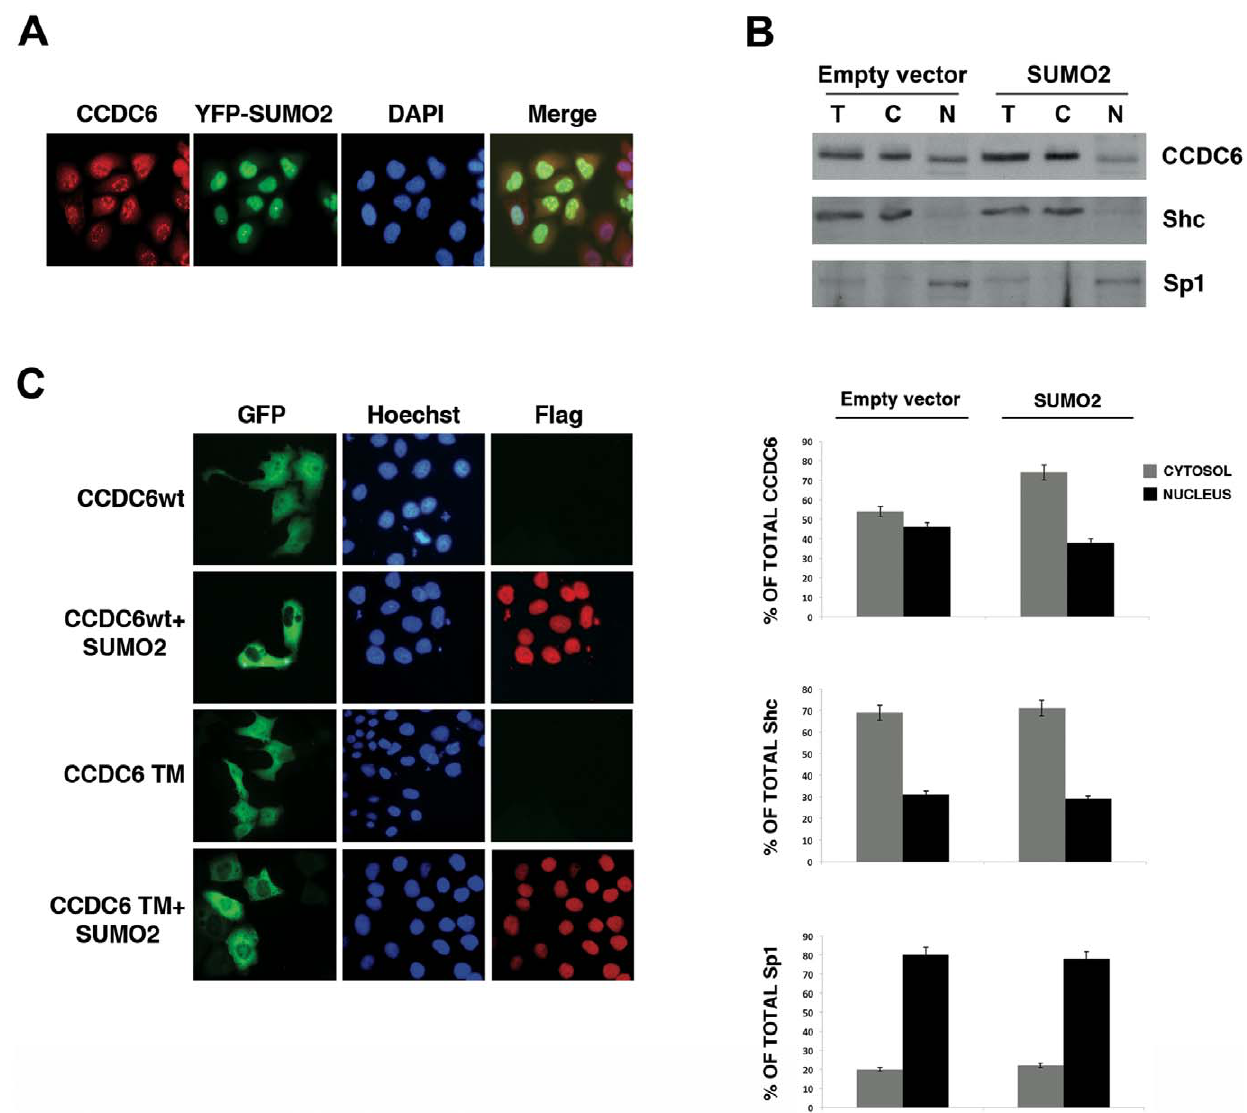
Figure 3. Intracellular localization of CCDC6-SUMO2 complex. A) HeLa YFP-SUMO2 cells were immunostained with the anti-CCDC6 antibody recognizing endogenous CCDC6. B) Endogenous CCDC6 were detected by immunoblotting with anti-CCDC6 primary antibody a SDS-PAGE of cytoplasmic and nuclear protein fractions obtained by HeLa cells, transfected with YFP-SUMO2 or YFP-empty vector. Anti-SP1 and anti-Shc were utilized as nuclear and cytosolic proteins control, respectively. Densitometric analysis has been performed by Image J Software, and the results of three experiments were plotted as percent of nuclear and citosolic fraction. Error bars represent SD. C) HeLa cells were transfected with expression vectors encoding FLAG-SUMO2 together with CCDC6-wt or -TM (KKK74, 266, 424RRR) fused to GFP epitope and immunostained with anti-FLAG monoclonal antibody. Hoechst staining is shown where indicated.